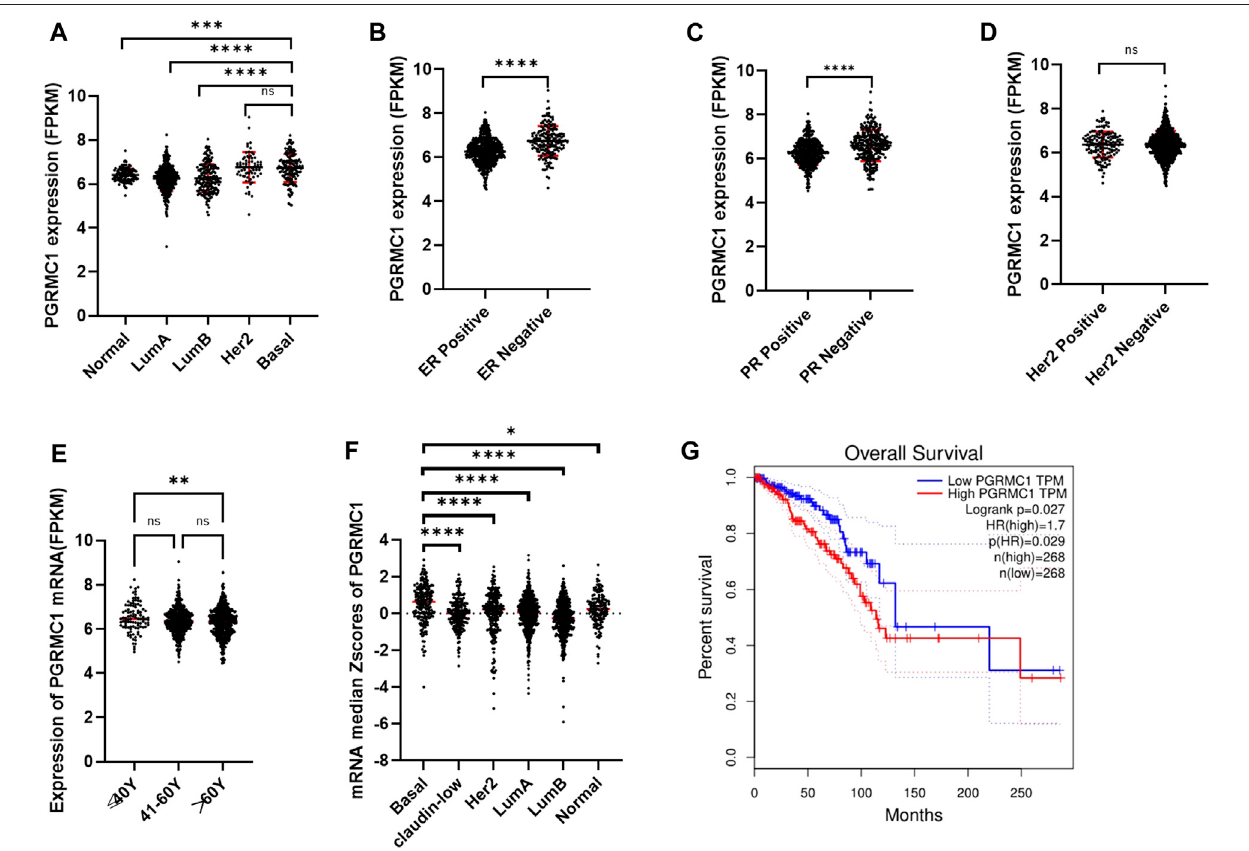
FIGURE 1 | Expression characteristics and prognostic value of PGRMC1. (A) The mRNA expression of PGRMC1 in different types of breast cancer from TCGA- BRCA. (B) The mRNA expression of PGRMC1 in different ER states. (C) The mRNA expression of PGRMC1 in different PR states. (D) The mRNA expression of PGRMC1 in different Her2 states. (E) The mRNA expression of PGRMC1 in different groups of age. (F) The mRNA expression of PGRMC1 in different types of breast cancer from the METABRIC. (G) The survival curvesfor low and high PGRMC1 expressed groups by GEPIA2. (*means p < 0.01 ** means p < 0.001,*** means p < 0.0001,**** means p <